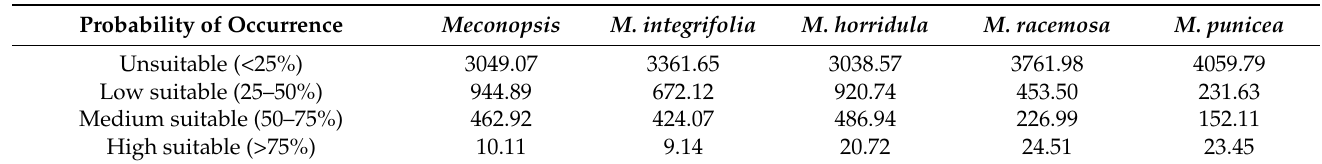
Table 4. The areas of different suitable habitat of Meconopsis species based on model predictions under current climate scenario. (Unit: 10 3 km 2